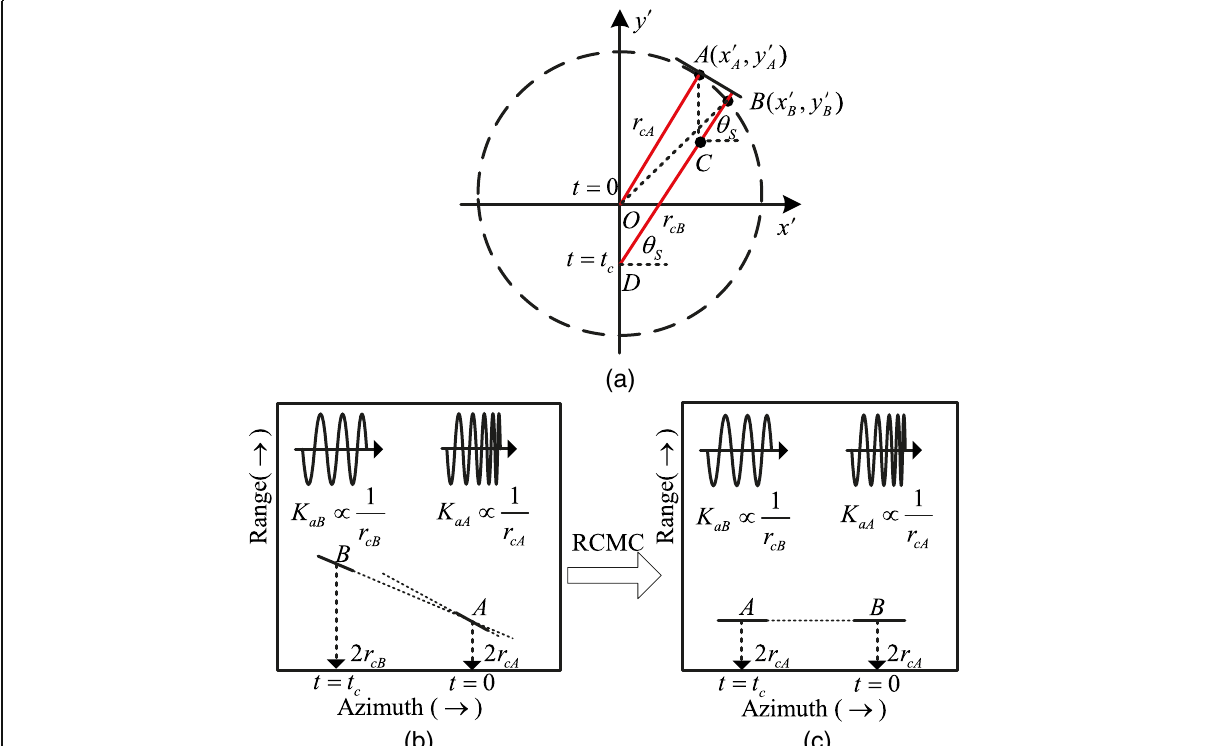
Fig. 8 a Circle space. A and B lie on the circle when they share the same R total (0; r c , t c ). b Data space before RCMC. c Data space after RCMC. Range histories of A and B have been shifted into a same range